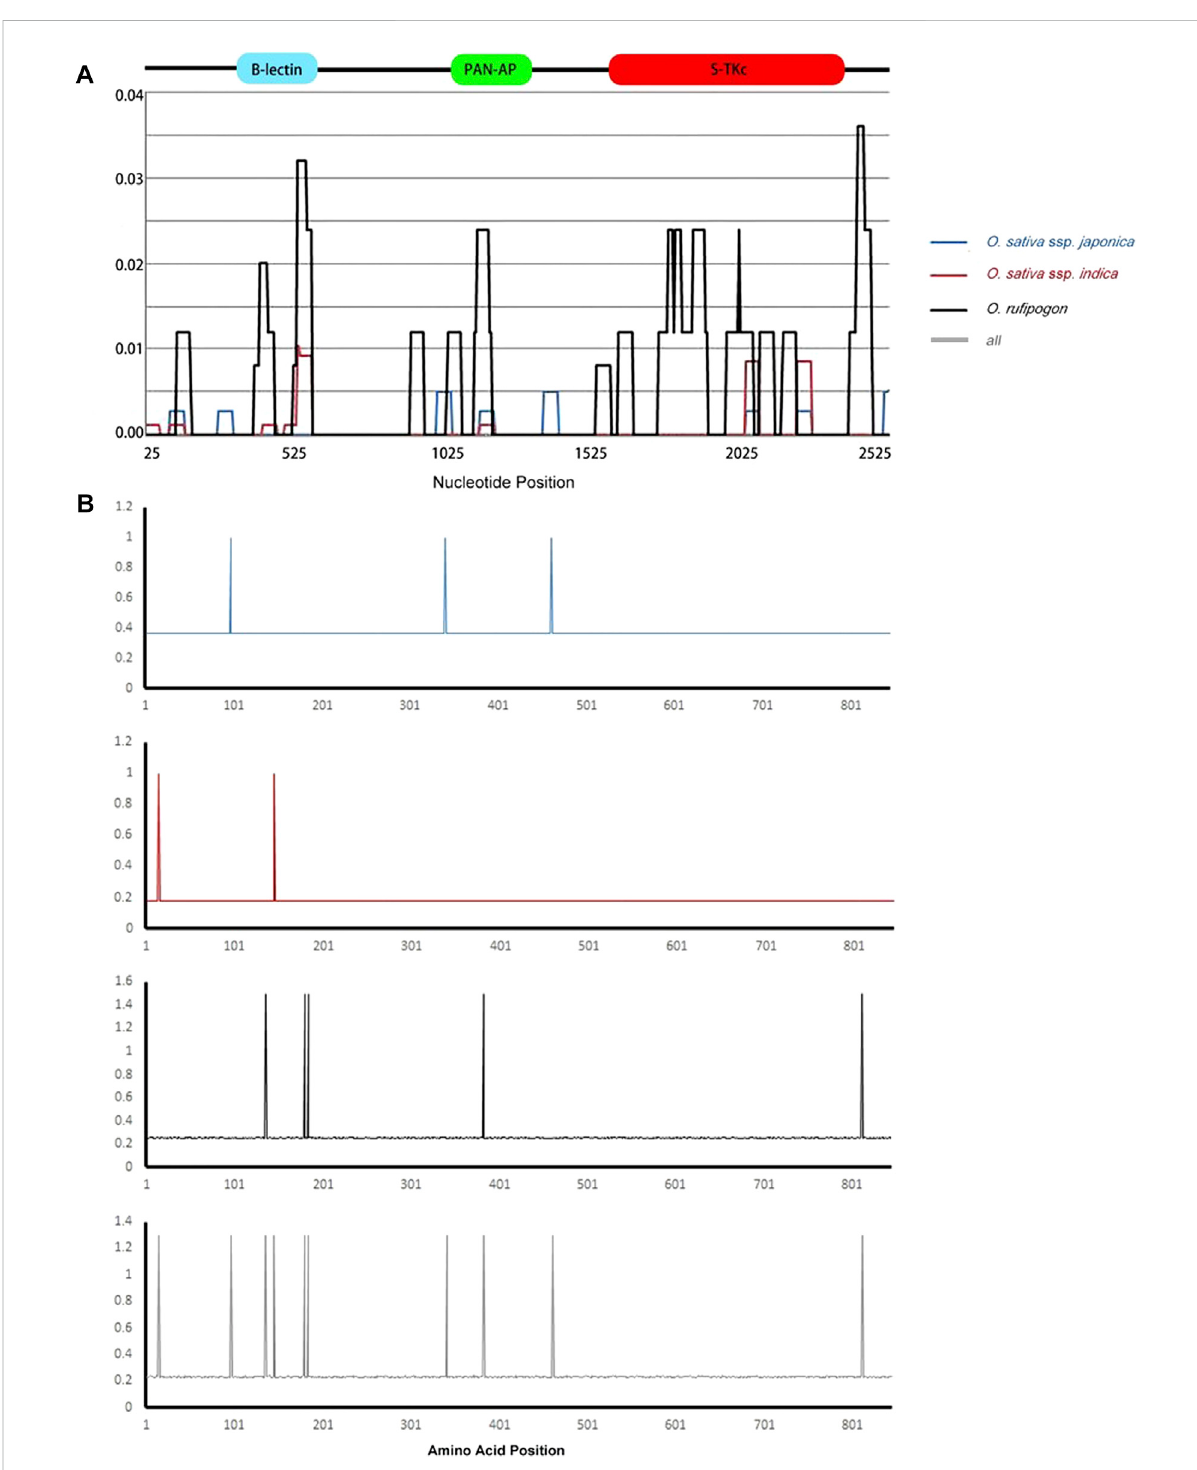
FIGURE 1 Sliding window of nucleotide diversity and positive-selection sites of Pi-d2 in Oryza sativa ssp. Japonica , O. sativa ssp. indica and O. ru fi pogon subgroups. (A) Thenucleotidediversityof Pi-d2 inthreesubgroups.The X -axisrepresentsthenucleotidepositionof Pi-d2 ;the Y -axisindicatesvalue of nucleotide diversity per site. Values were assigned to the nucleotide at the midpoint of 5 bp. (B) The positive-selection sites of the Pi-d2 allelic variants under MEC model. The X -axis represents the position of the Pi-d2 amino acids; the Y -axis indicates the ratio of non-synonymous substitution (Ka) to the rate of synonymous substitution (Ks) (Ka/Ks); the B-lectin, PAN-AP, and S-TKc domains are marked on the corresponding region abovethesliding windows.Structure ofthe Pi-d2 codingregion isshown atthetop. O.sativa ssp. Japonica , O. sativa ssp. indica , O.ru fi pogon and the all group are represented by blue, red, black and gray lines,